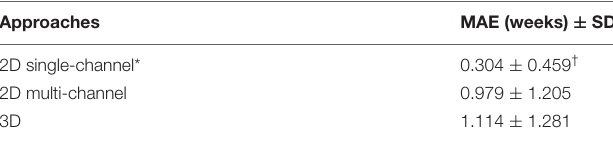
TABLE 2 | Prediction performances of the deep learning networks using different inputs.